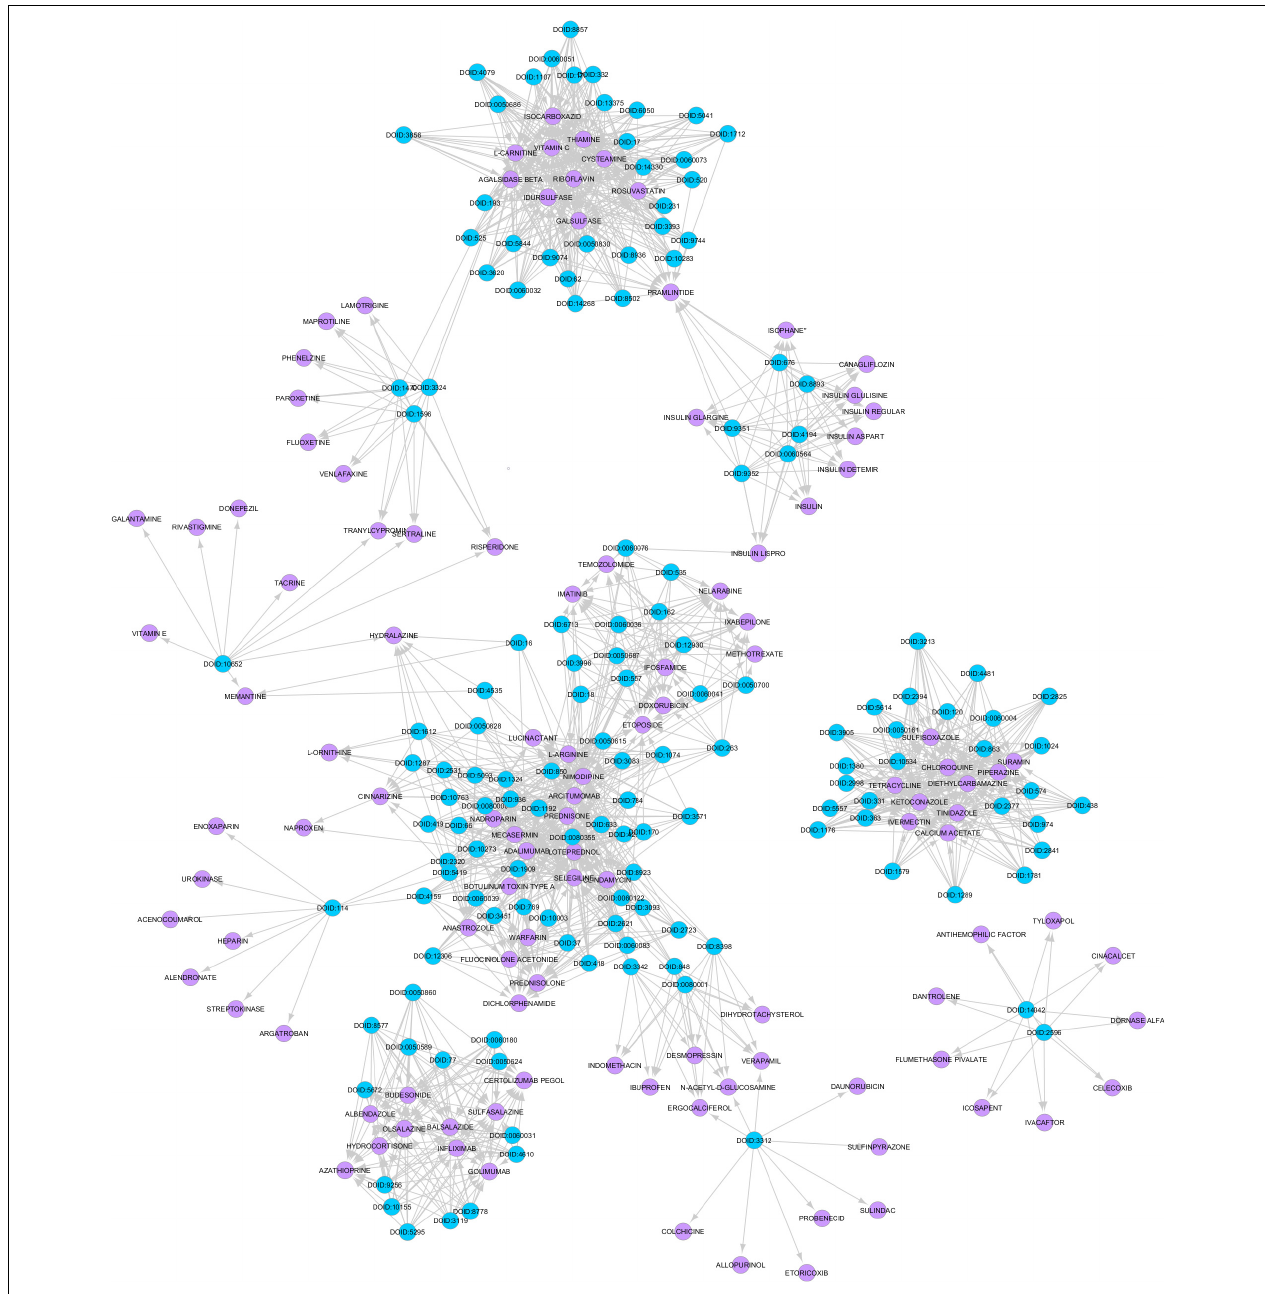
FIGURE 4 | Disease Drug Knowledge Graph constructed from muscle atrophy related diseases and drugs used for their treatment obtained from the drug bank database. The blue colored circles are the disease nodes and the purple colored circles are the